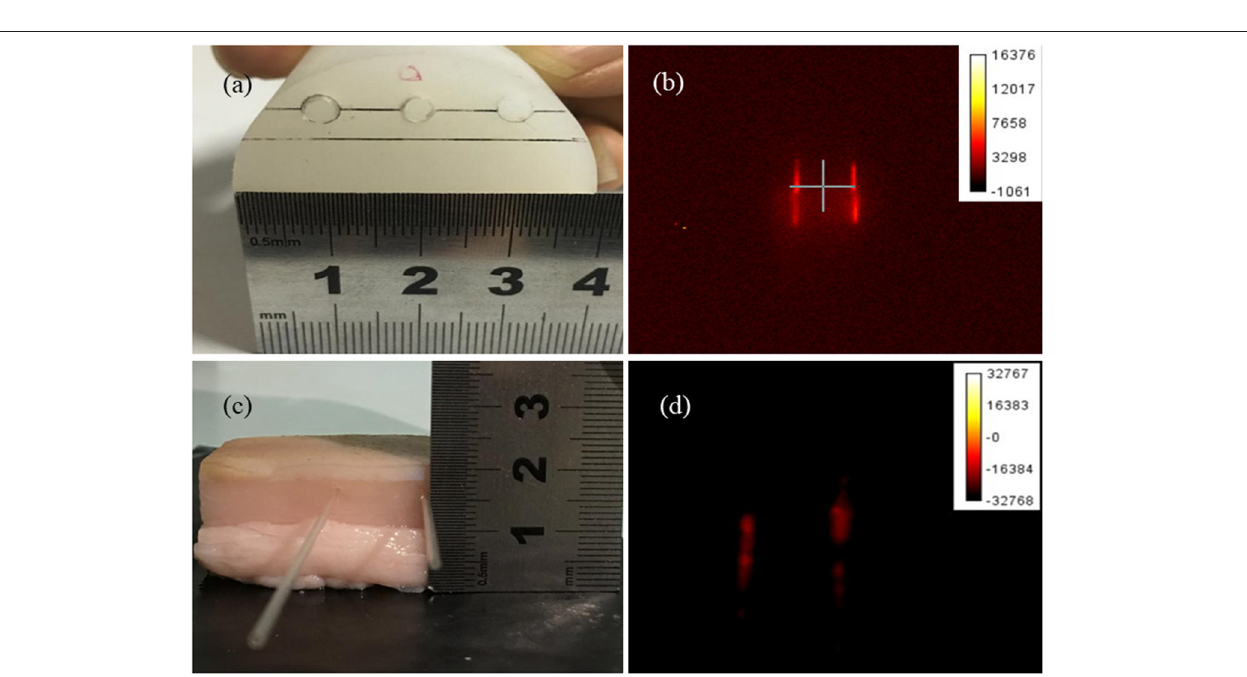
FIGURE 7 | The photographs of the phantom (a) and pork tissues (c) , and the NIR images of BaF 2 :Nd NP dispersion (4 mg/mL) in the phantom (b) and pork tissues (d) .